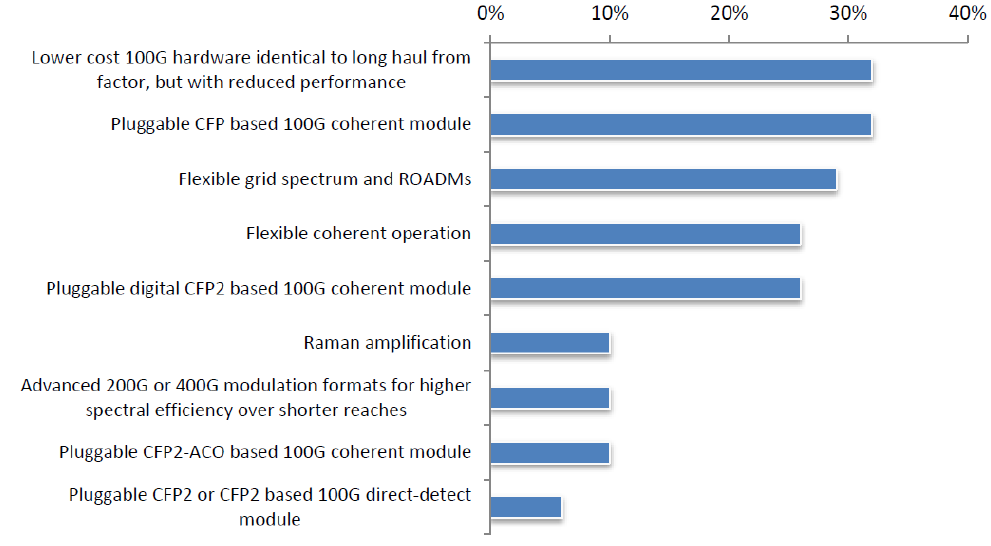
Figure 7. Results of the Infonetics survey about technologies required for metro networks [12].